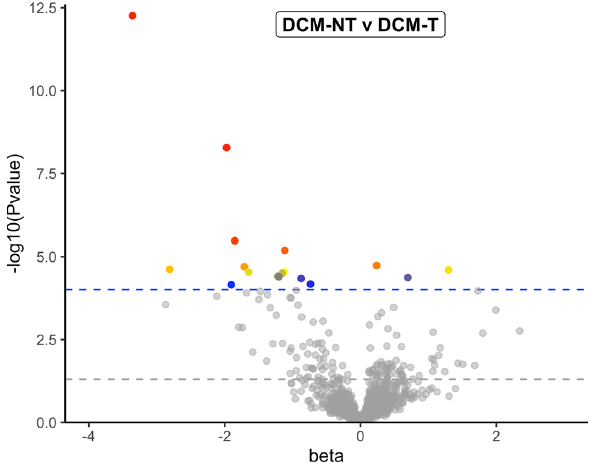
Figure 2. Illustration of metabolites that were significantly different between groups at baseline in 46 dogs with dilated cardiomyopathy (DCM): 38 dogs with DCM eating non-traditional diets (DCM-NT) and 8 dogs with DCM eating traditional diets (DCM-T) at baseline. Metabolites plotted in gray have P values above the cutoff of 9.78E-05 and are considered not statistically significantly different between disease groups, whereas metabolites in colors were statistically significant with a P value < 9.78E-05. The beta values, where a negative value denotes higher levels in the DCM-NT diet group, are plotted against the negative of log 10 ( P